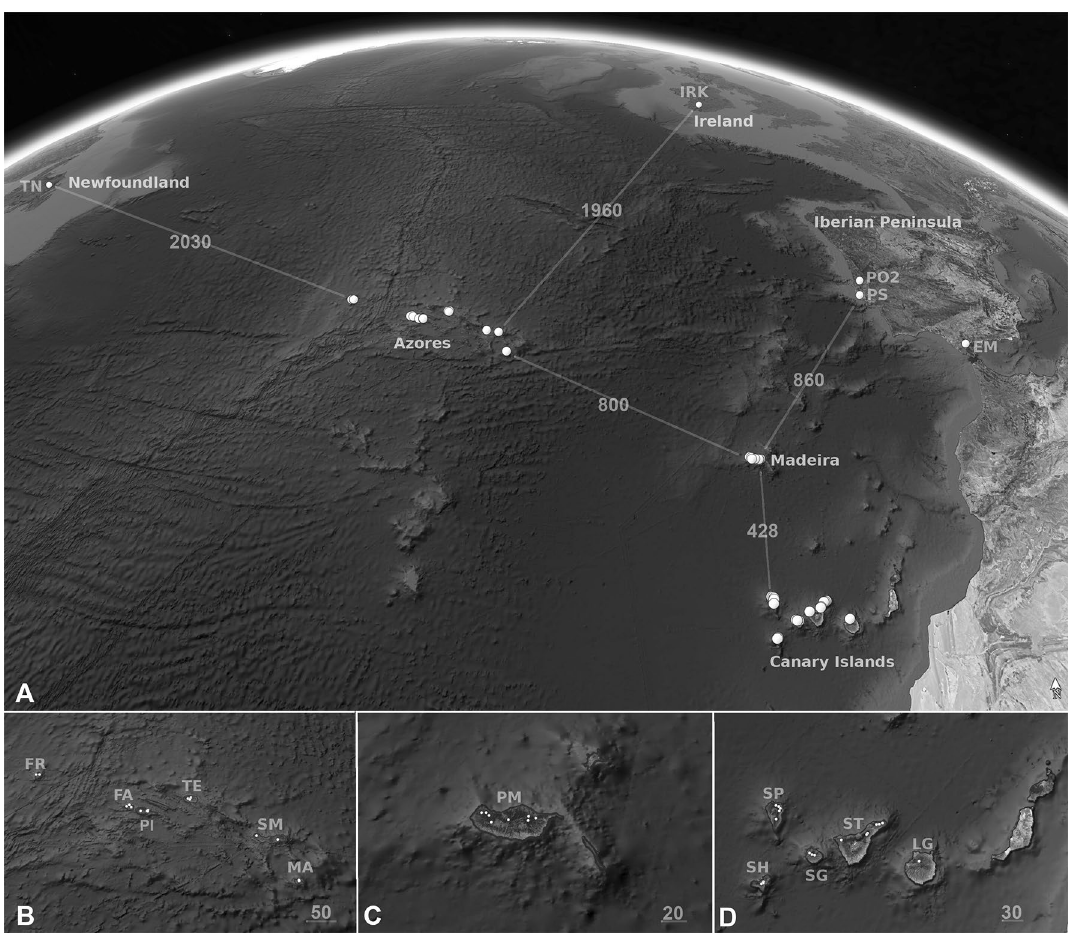
Figure 1. Map of the sampling sites (white dots) for Lobaria immixta , L. macaronesica and L. pulmonaria . ( A ) Overview of the sampling sites. ( B ) Azores. ( C ) Madeira. ( D ) Canary Islands. Numbers represent geographic distances (km). Base map: Google Earth Pro v. 7.3.3.7786, https:// earth. google. com/. Population names as in Table 1. The figure was compiled in GIMP v. 2.8, https:// www. gimp.